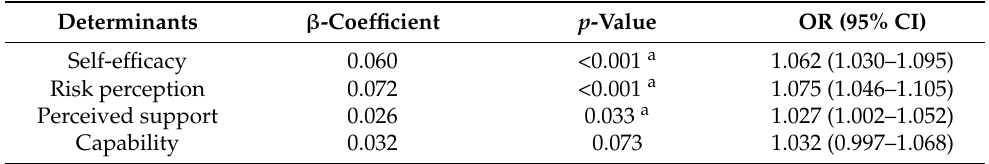
Figure 1. Feature selection using the LASSO regression model for COVID-19 vaccination intentions. ( a ) Variable selection by the LASSO binary logistic regression model. A coefficient profile plot was constructed against the log (lambda) sequence. Four variables with nonzero coefficients were selected by deriving the optimal lambda. ( b ) Following verification of the optimal parameter (lambda) in the LASSO model, we plotted the partial likelihood deviance (AUC) curve versus the log (lambda) and drew dotted vertical lines based on the 1 standard error criteria: the LASSO Least Absolute Shrinkage and Selection Operator. Table 3. Logistic regression analysis of the predictors for vaccination